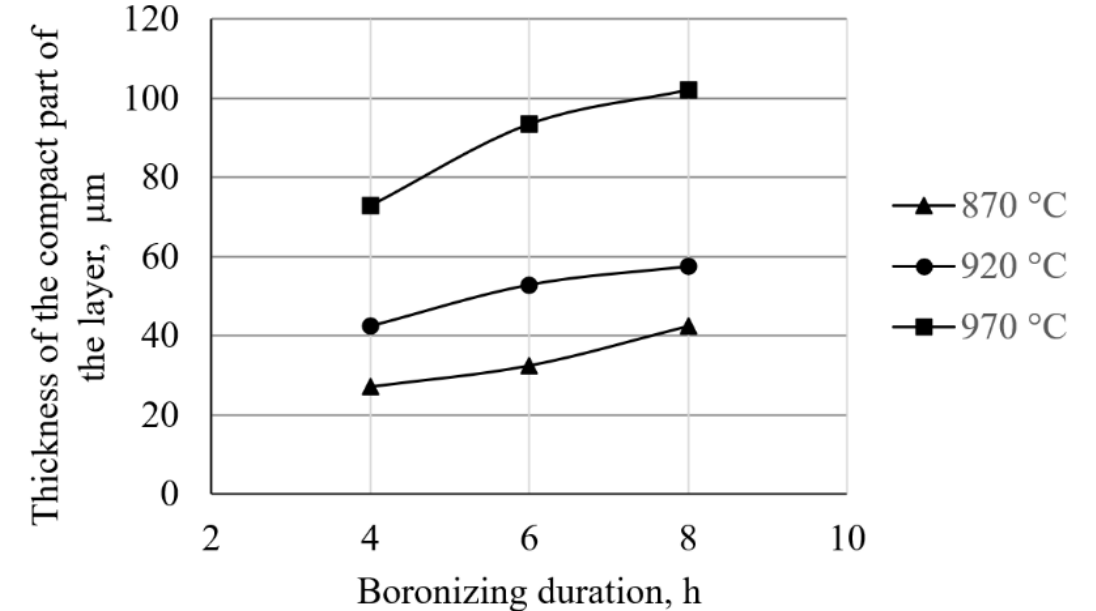
Figure 6. Dependence of the thickness of the compact part of the boride layer on the temperature.